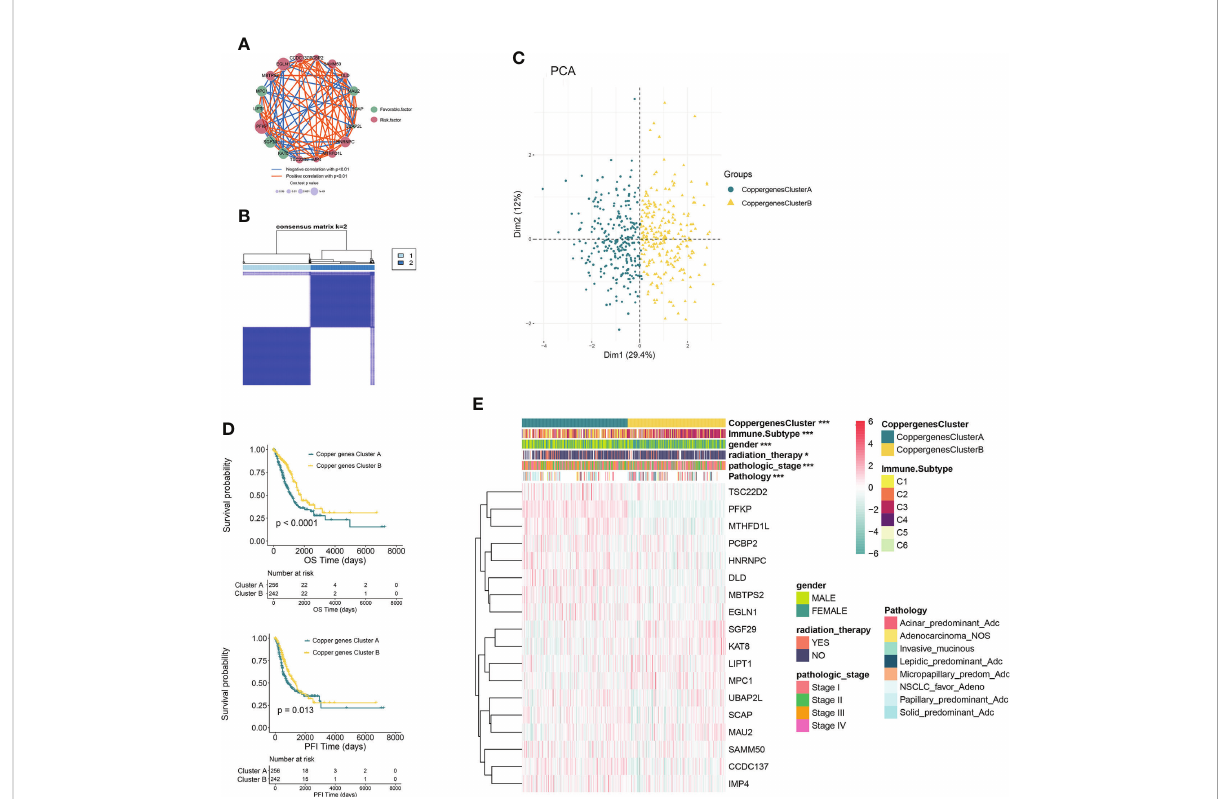
FIGURE 2 CRG subtypes and clinicopathological and biological characteristics of two distinct subtypes of samples divided by consistent clustering. (A) Interactions among CRGs in LUAD. The line connecting the CRGs represents their interaction, with the line thickness indicating the strength of the association between CRGs. Blue and orange represent negative and positive correlations, respectively. (B) Consensus matrix heatmap de fi ning two clusters (k = 2) and their correlation area. (C) PCA analysis showing a remarkable difference in transcriptomes between the two subtypes. (D) Kaplan – Meier analysis showing 18 CRGs related to the PFI and OS (Copper genes Cluster A: 263; Copper genes Cluster B: 244). (E) Differences in clinicopathologic features and expression levels of CRGs between the two distinct subtypes. *P<0.05, ***P<0.001. CRGs, cuproptosis-related genes; LUAD, lung adenocarcinoma; TCGA, The Cancer Genome Atlas; PCA, principal components analysis; PFI, progression free interval; OS, overall